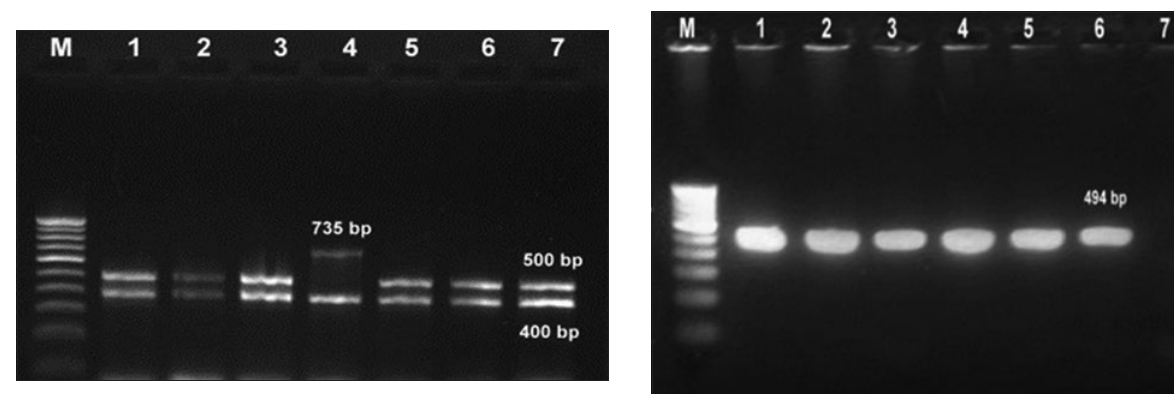
Figure-3: Gel electrophoresis of polymerase chain reaction (PCR) product fla A (450 bp), Lane M: 100 bp ladder, Lane 1: Escherichia coli , Lanes 2-20: fla A PCR product.